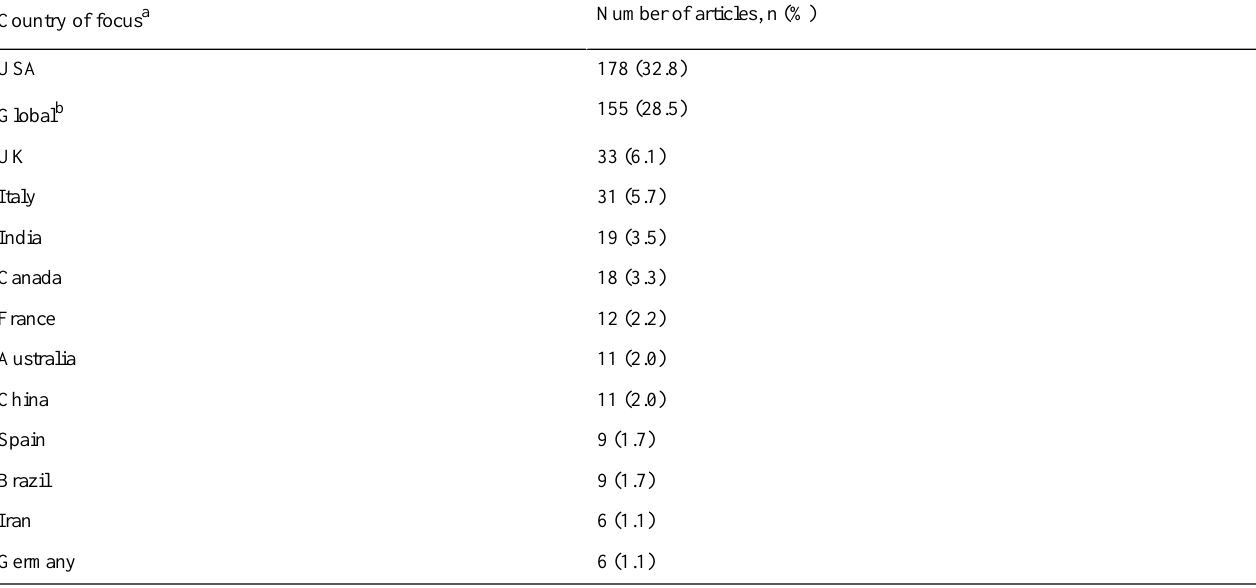
Table 2. Geographic focus of published articles included in the review